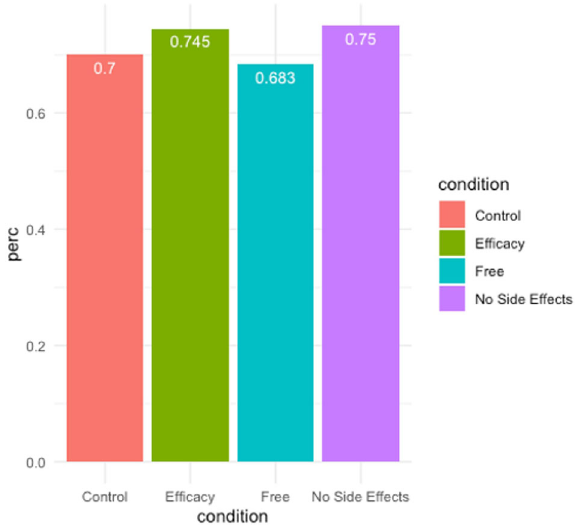
Fig. 4 Percent in each condition who say “ yes ”